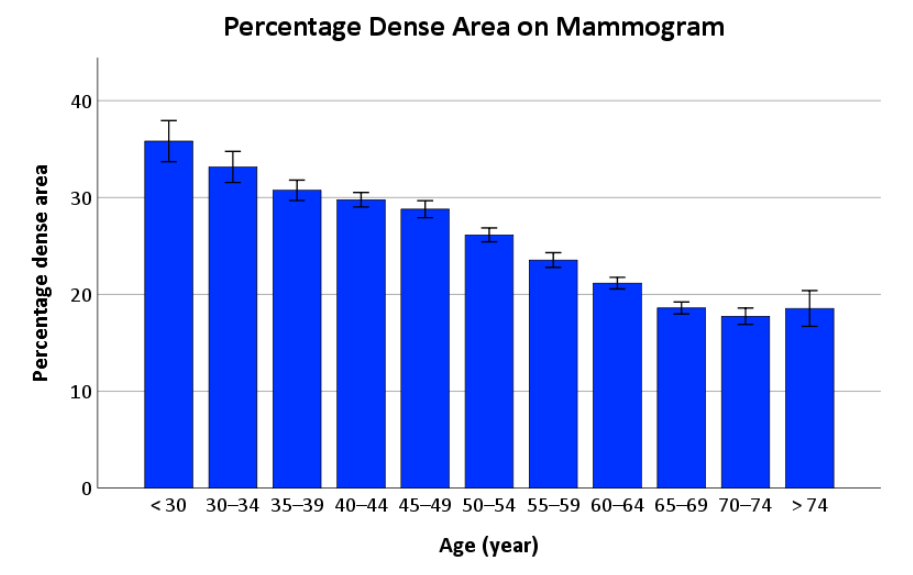
Figure 2. Bar chart showing percentage dense area of the breast for various age groups. Note: 1 The error bars depicted the standard error of the mean. 2 The test for linearity showed a significant difference between groups ( p < 0.001) but the deviation from linearity was non-significant ( p = 0.514).